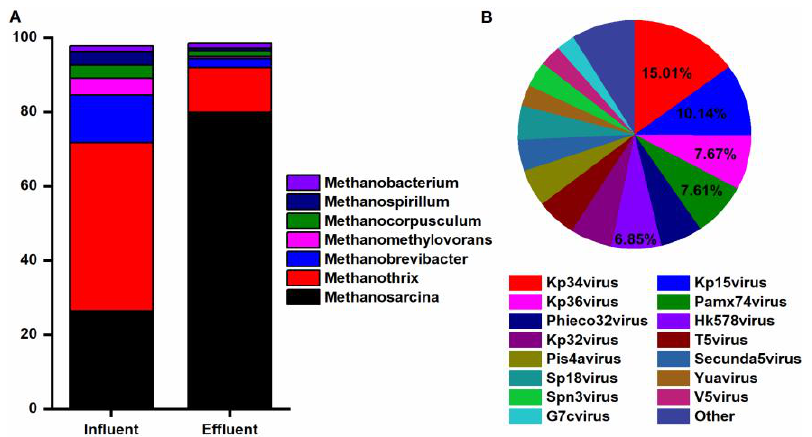
Figure 3. Metagenomics analysis of archaeal and viral communities at genus level, visualized by Origin 2022. The top 7 abundant archaeal genera ( A ) and the top 15 abundant viral genera ( B ). Relative abundance is expressed as a percentage of the total valid sequences for each sample for each archaeal/or viral taxonomic unit. Since viruses were not annotated at the genus level in the effluent, Figure 3B only shows the abundance of virus genera in the influent.